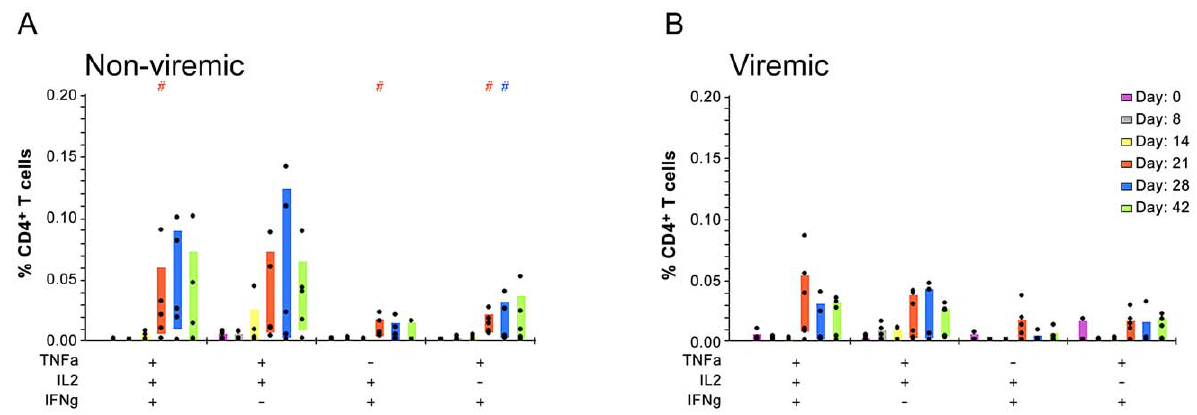
Figure 3. Non-viremic vaccinees may produce more multifunctional T cells than viremic volunteers. A. Multifunctional CD4 + T cells produced by non-viremic group. B. Multifunctional T cell profile for viremic group. # denotes statistically higher % CD4 + cells producing the cytokine profiles indicated compared to Day 0 ( p , 0.05 by Wilcoxon’s rank sum test). Each day is represented by a separate color. A ‘‘ + ’’ or ‘‘ 2 ’’ indicates whether a particular cytokine (TNF a , IFN c and/or IL-2) is present. Shaded bars denote interquartile ranges.